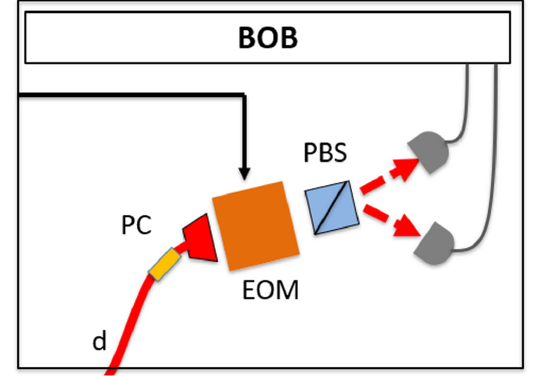
FIG. 13. Schematic representation of Bob ’ s station and tools to recover the input